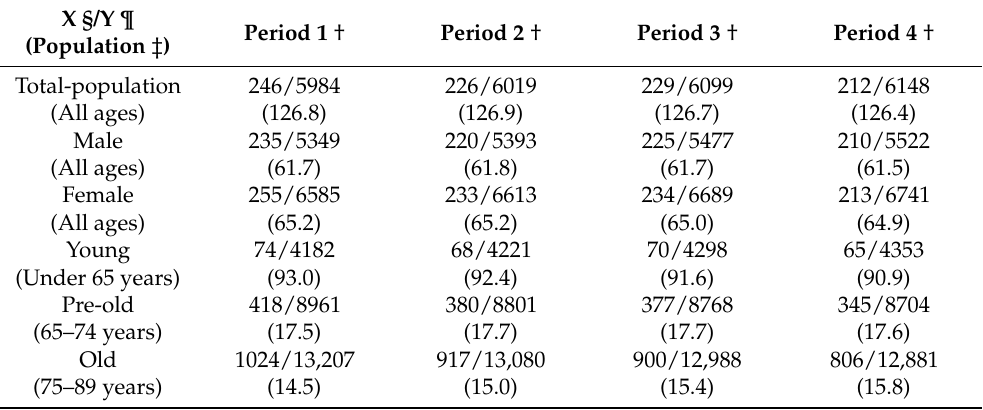
Table 1. Demographics of annual reimbursement claims and population over four